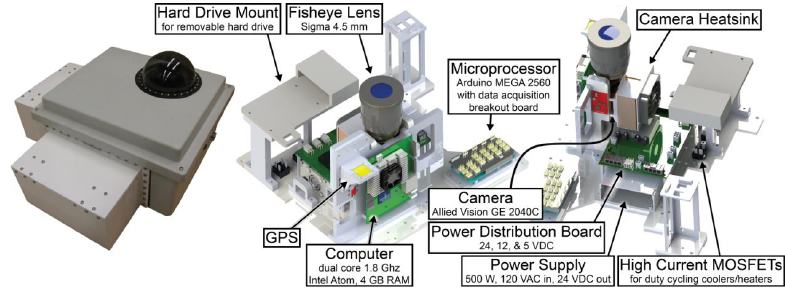
Figure 1. The UCSD Sky Imager enclosure (left) and a CAD model showing the layout of system components Fig. 1. The UCSD Sky Imager enclosure (left) and a CAD model showing the layout 3 of system components (right).. 4